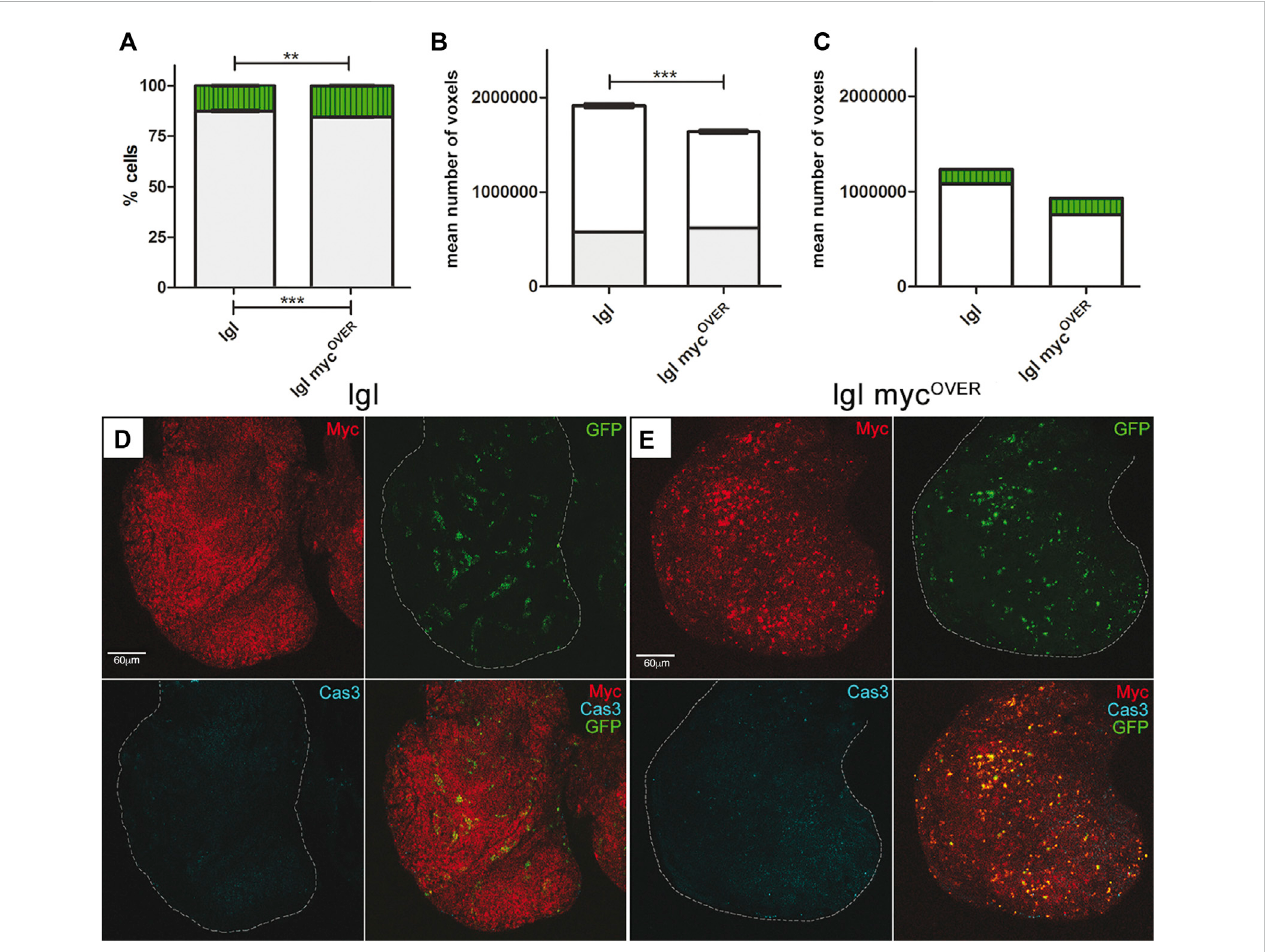
FIGURE 2 Apoptosis inhibition rescues both tumor size and composition. (A) Percentage of GFP + (green) and GFP − (grey) cells in treated lgl tumors collected at 8 days AEL after induction of neutral (n = 64) and myc OVER (n = 62) clones at 6 days AEL. See Supplementary Table S1 for plain genotypes. (B) Mean volume of the same samples as in A calculated from the images acquired immediately before dissociation (8 days AEL). The grey part of the bars represents the pre- induction volume (6 days AEL, n = 58 for neutral and n = 55 for myc OVER samples). (C) Relative volumes of GFP + (green) and GFP − (white) cells in neutral and myc OVER samples after clone induction and treatment, calculated as described in the Methods section. Statistical signi fi cance and ±SEM are indicated. (D) MYC(red)andactivatedCas3(cyan)stainingof lgl treatedtumorscollectedat8 daysAELinwhichGFP + , lgl neutralcloneswereinducedat6 daysAEL. (E) MYC (red) and activated Cas3 (cyan) staining of lgl treated tumors collected at 8 days AEL in which GFP + , lgl myc OVER clones were induced at 6 days AEL. All the images represent disc cross-sections. Scale bars are indicated for each